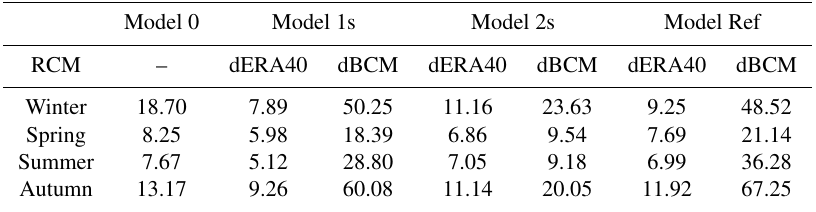
Table 3. Average mean square error for models trained on dERA40 data. The values in the table are averages across the eight folds for each